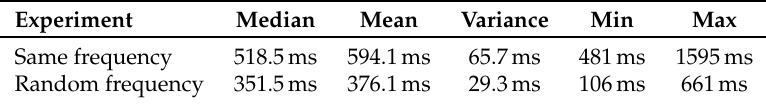
Table 2. Overview of command response time